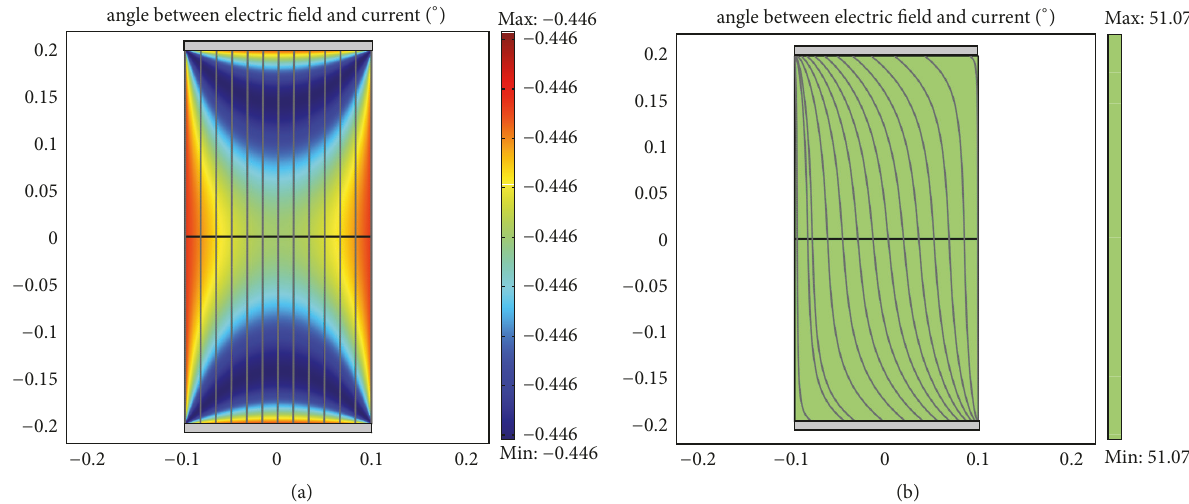
Figure 4: (a, b) Angle between electric field and current density in a device of Figure 2(a) operated like in Figure 2(a). The plots were obtained by FEM simulations with COMSOL MULTIPHYSICS. In (a) we have zero magnetic field and small mechanical stress (𝜋 12 − 𝜋 11 )𝜎 𝑥𝑦 = tan 0.446 ∘ . In (b) we have zero stress and even large magnetic field with 51.078 ∘ Hall angle. As predicted by [28] the Hall angle is perfectly homogeneous throughout the device (b), but surprisingly in the piezoresistive case (a) the angle only between − 0.445766 ∘ and − 0.445752 ∘ ). This seems to be the reason why the analogy [2] between Hall effect and piezoresistive effect works for this